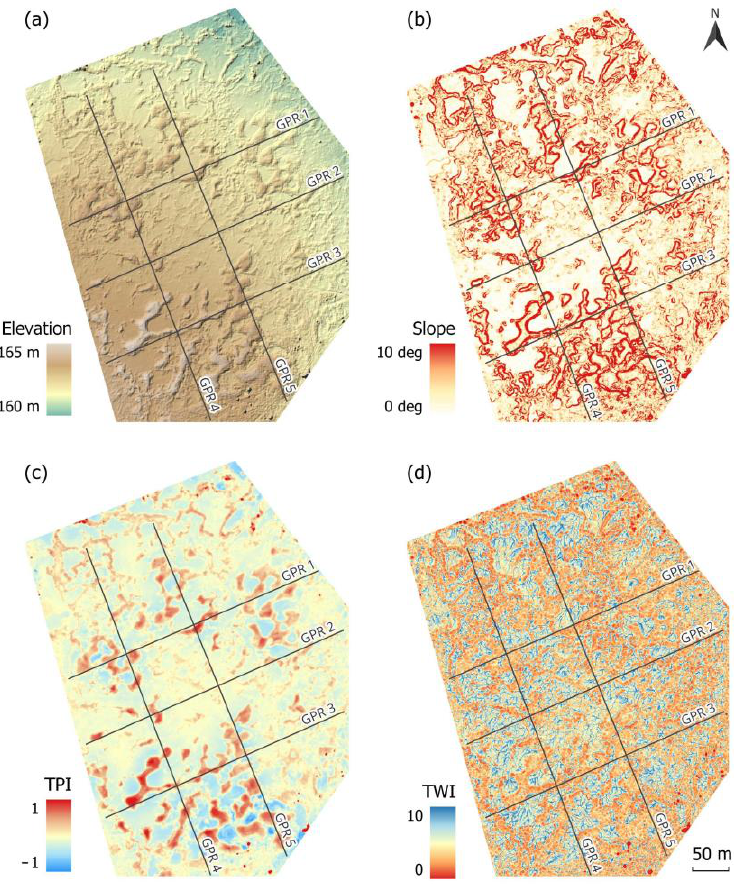
Figure 4. DEM ( a ) and morphometric dataset: slope ( b ), topographic position index ( c ), and topo- graphic wetness index ( d ) with GPR profile lines.